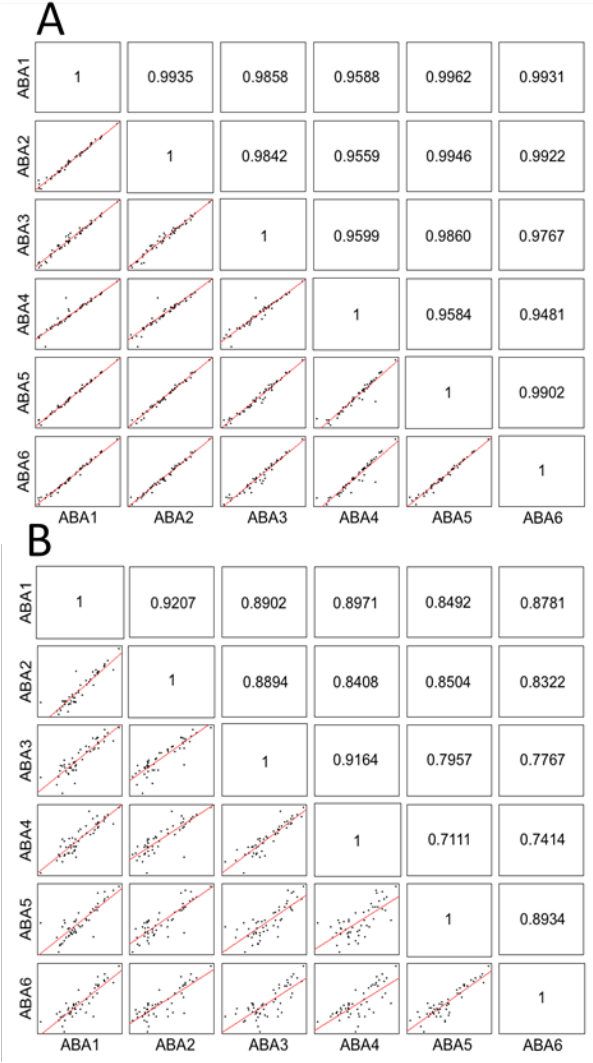
Figure 2. Linear correlation analysis of six replicates for the ABA affinity-based experiment for the ( A ) 50 most abundant proteins and the ( B ) 50 least abundant proteins quantified by nano-LC-MSMS analysis and precursor ion area detection. The concentrations of the measured proteins in plasma were based on values extracted from the plasma proteome database (http: // www.plasmaproteomedatabase. org). Depicted data are